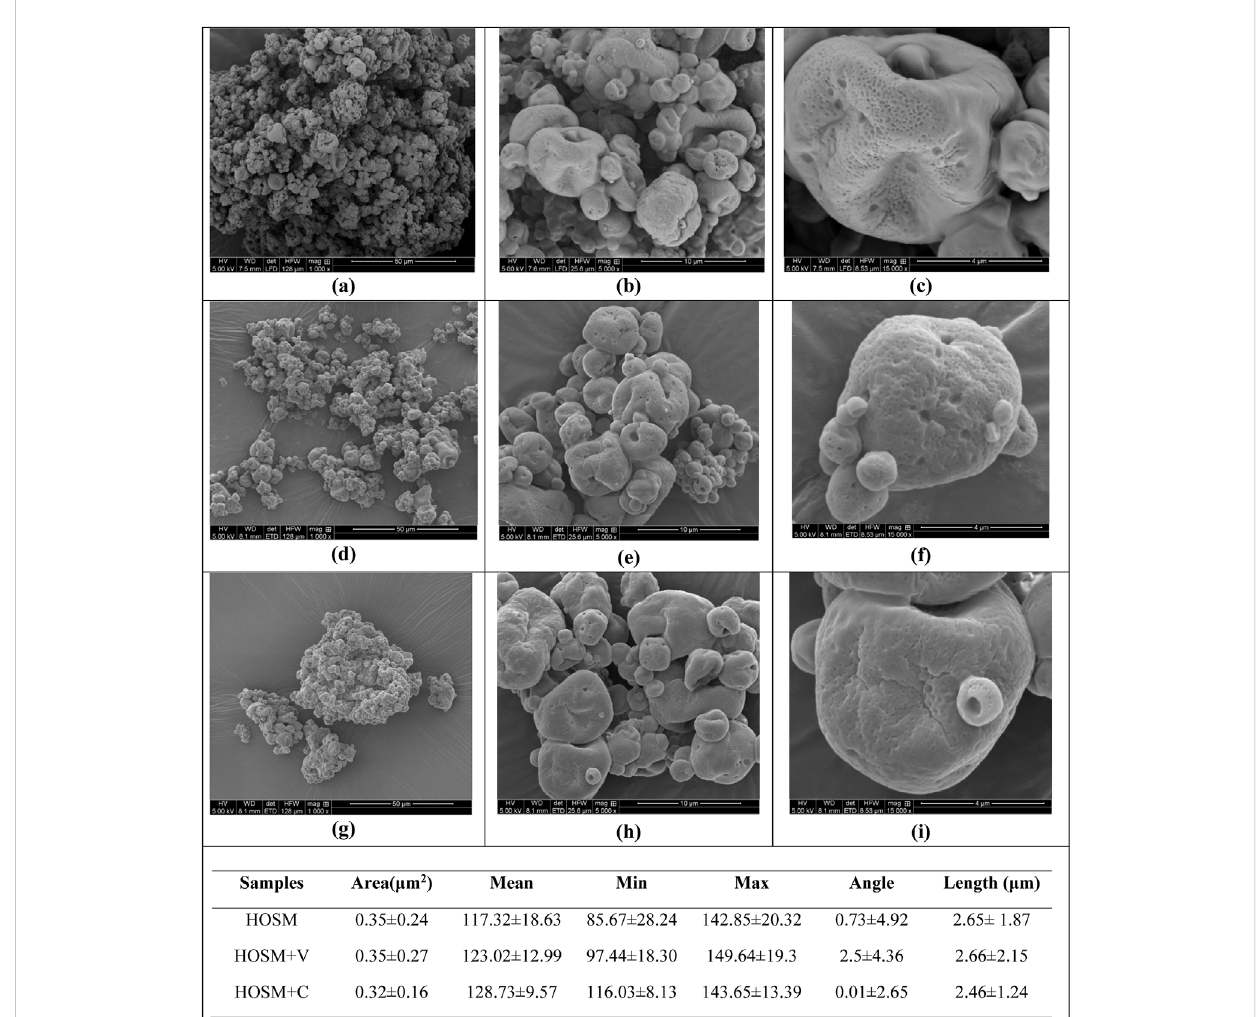
FIGURE 3 SEM images of spray dried HOSM powder at magni fi cation (A) ×1,000 (B) ×5,000 (C) ×15,000 and fl avoring components such as vanilla (D – F) and chocolate (G – I) at the same magni fi